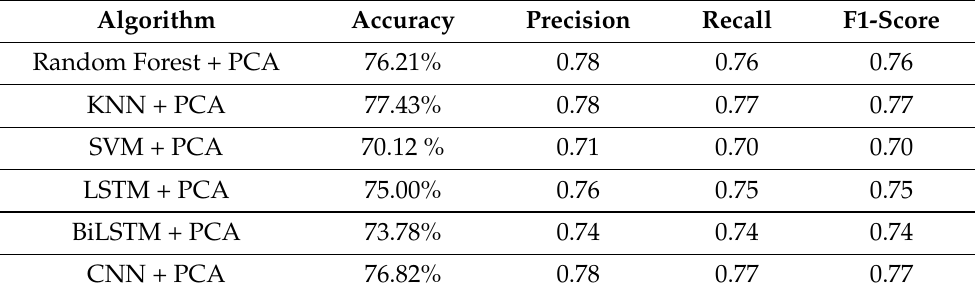
Table 3. Machine learning results using raw image data with PCA.